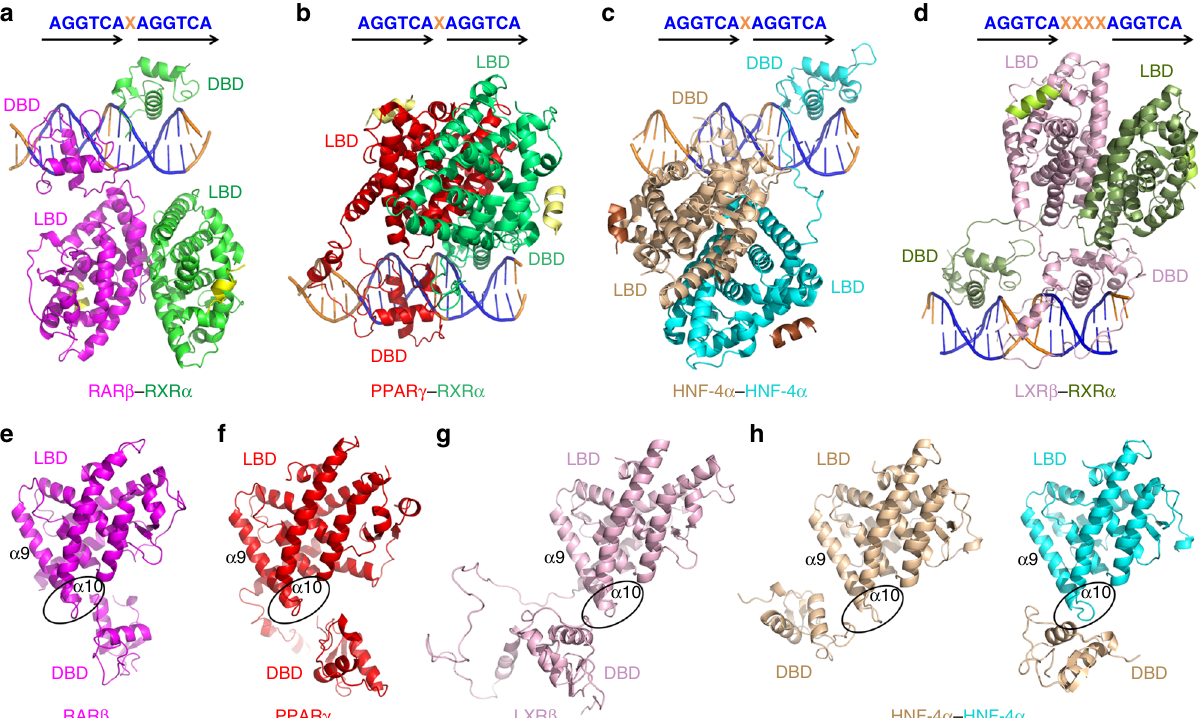
Fig. 4 The different architectures of multi-domain NRs on DNA. a – d Crystal structures of RAR β – RXR α heterodimer ( a ), PPAR γ – RXR α heterodimer ( b ), and HNF-4 α homodimer ( c ) on DR1 DNA, and that of LXR β -RXR α heterodimer on DR4 DNA ( d ). The AGGTCA sites are colored in blue for each structure. e – h Relative positions of LBDs and DBDs of RAR β ( e ), PPAR γ ( f ), LXR β ( g ), and HNF-4 α ( h ). All the LBDs are in the same orientation, with their α 9 and α 10 helices labeled, and their “ patch ” regions highlighted with clear ovals. For HNF-4 α homodimer, one DBD is shown near to the LBDs from the same monomer (in wheat color) or from the other one (in cyan) RAR α –RXR α –DNA